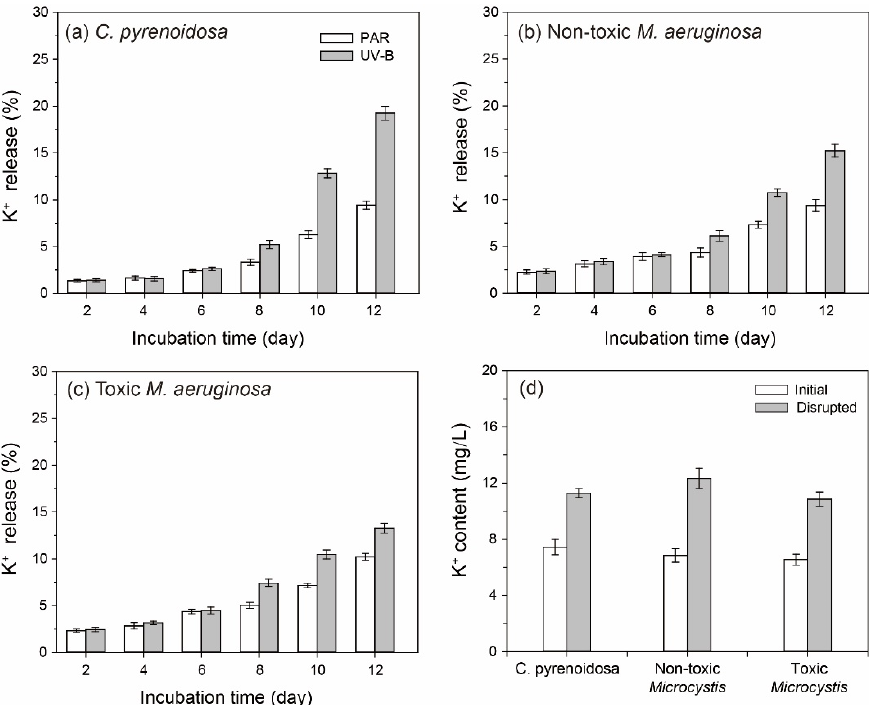
Figure 4. (a − c) The release rates of K + by three species in the PAR and UV ‐ B treatments in the mono ‐ cultures. (d) A comparison of the initial and ultrasonic disrupted cells of three